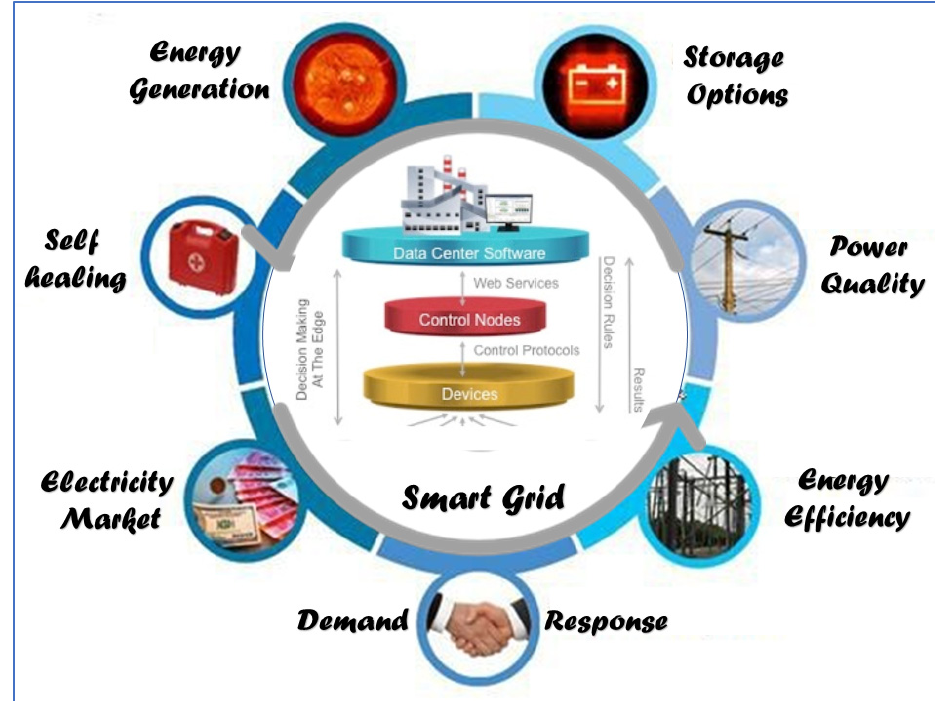
Figure 1. Smart electric grid.